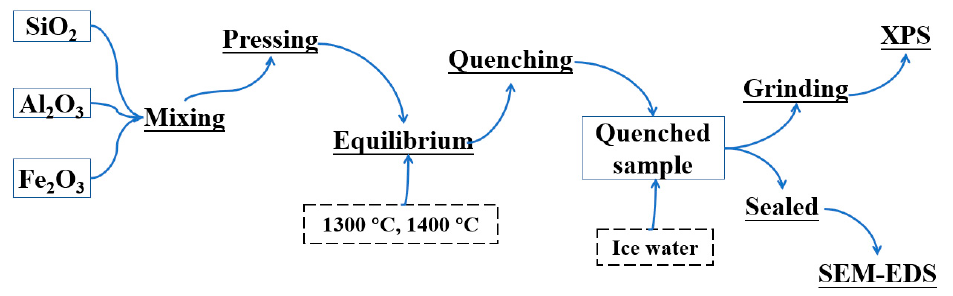
Figure 1. Experimental processes for the thermodynamic equilibrium-quenching technique. High-purity oxide powders of SiO 2 (99.99 wt.%), Al 2 O 3 (99.99 wt.%) and Fe 2 O 3 (99.9 wt.%) from Sinopharm Chemical Reagent Co., Ltd., shenyang, China, were employed as